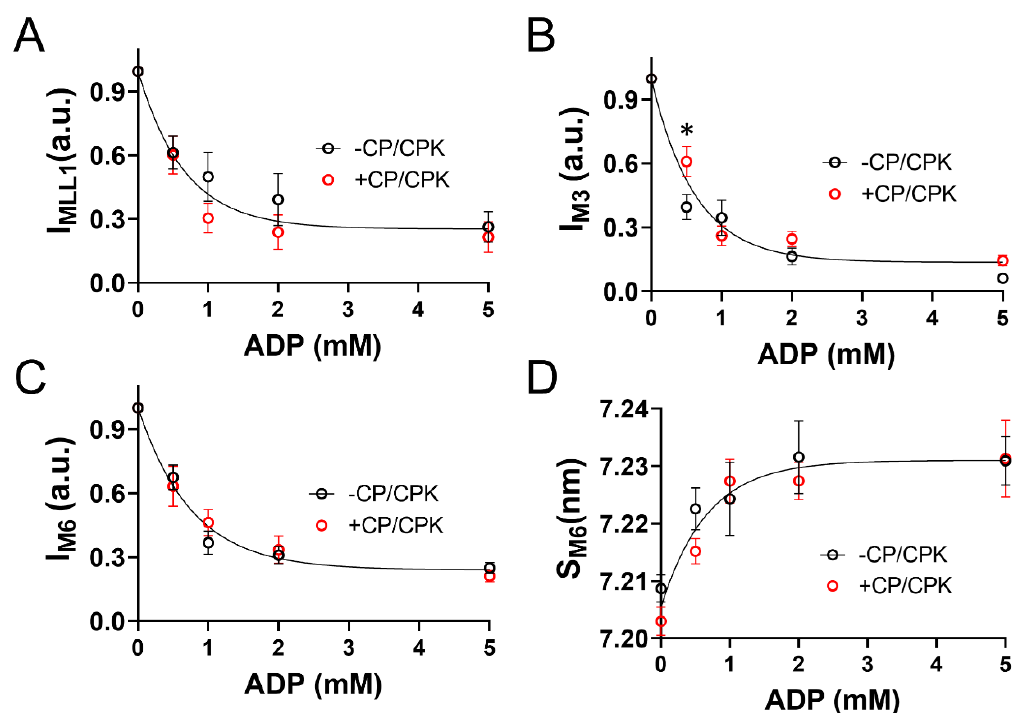
Figure 3. Myosin heads became more disordered as [ADP] increased under relaxing conditions. Intensity of the ( A ) first order myosin-based layer line (I MLL1 ), ( B ) third order myosin-based meridional reflections (I M3 ), ( C ) sixth order of myosin-based meridional reflection (I M6 ), and ( D ) spacing of the sixth order of myosin-based meridional reflection (S M6 ) were plotted against [ADP] in the presence and absence of CP and CPK. Intensity values were normalized to the 0 mM [ADP] value within each fiber for data shown in panels ( A – C ). Two-way linear mixed model analysis showed significant ( p < 0.001) main effects of ADP for data in all panels. In Panel ( B ), there was also a main effect of CP/CPK ( p = 0.03), with * indicating a Fisher’s LSD post hoc difference between − CP/CPK and +CP/CPK at a single [ADP] at p < 0.05. The number of fibers was 9 for each group.